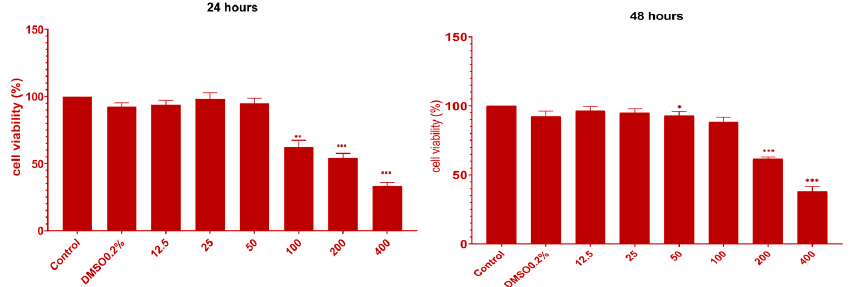
Figure 4. The viability of the CAL 27 cells after UBE (µg/mL) treatment for 24 h (left) and 48 h